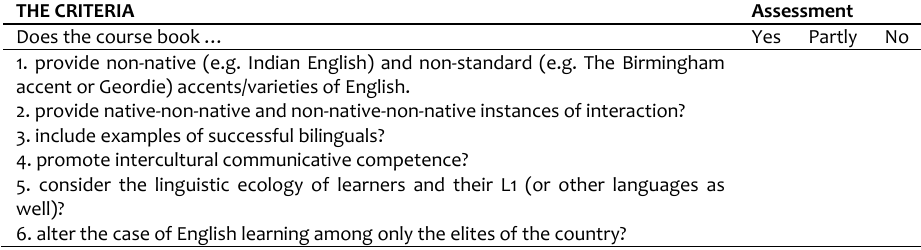
Table 1 . The Sociolinguistic Evaluation Checklist for English Textbooks THE CRITERIA